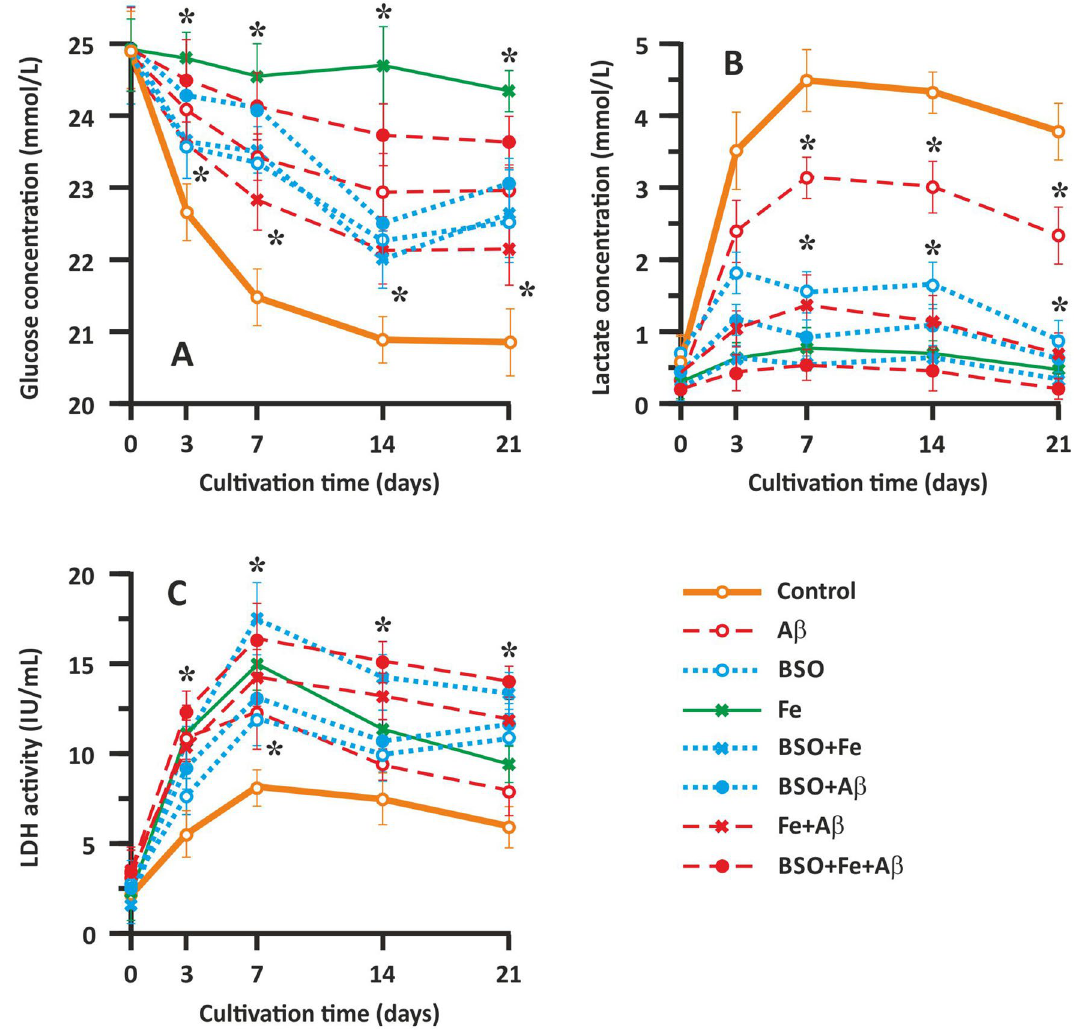
Figure 3. Effect of Aβ, BSO, and Fe 2+ on hippocampal cell metabolism and survival. ( A ) Change in the glucose concentration in the culture medium. ( B ) Change in the lactate concentration in the culture medium. ( C ) Change in LDH activity in the culture medium. Biochemical parameters reflecting cellular metabolism (glucose and lactate levels) and cell damage (LDH activity) in the extracellular medium were measured using Roche Cobas C311 and Cobas E411 automatic biochemical analyzers (Roche Cobas, Switzerland) and appropriate test kits. n = 10. * P < 0.05. The error bars indicate the mean ± count presented above and reflects cell metabolism, which gradually decreased. Fe application almost completely abolished glucose utilization, likely by causing oxidative stress and cell death (Fig. 3A). In the Aβ-treated groups (the Aβ, Fe + Aβ, and BSO + Fe + Aβ groups), intermediate toxicity was observed. Glucose utilization was most markedly affected in the BSO + Fe + Aβ group but less affected in Aβ group (Fig. 3A). The change in glucose content in the culture medium was similar between the Aβ group and the control group. Interestingly, wave- like fluctuations in glucose concentrations were observed in the BSO-treated groups (the BSO, BSO + Fe, and BSO + Aβ groups). Generally, the change in glucose concentrations in these groups was similar to that in the Aβ-treated groups, but there were two periods in which glucose utilization was abolished, i.e., 3–7 day of culture and 14–21 days of culture (Fig. 3A). The change in lactate accumulation in the neuronal cell medium was opposite of the change in glucose concentrations, which is expected and normal for metabolically active cells. In the control group, we observed lactate accumulation until the 7th day of culture, when the analyte concentration reached 4.51 ± 0.49 mmol/l (Fig. 3B). The lactate concentration in the control group gradually decreased after the 7th day and until the end of cultivation and finally reached a value of 3.84 ± 0.42 mmol/l. The change in lactate accumulation in the Aβ-treated groups (the Aβ, Fe + Aβ, and BSO + Fe + Aβ groups) resembled the change in glucose concentrations. The curves representing the change in the lactate concentration in these groups showed the same shape as the curve of the control group, but the concentrations were lower. Cells treated with Aβ alone showed less marked changes, with lactate concentrations reaching the maximal value (3.12 ± 0.27 mmol/l) on the 7th day of cultiva- tion and gradually decreasing to 2.44 ± 0.35 mmol/l (Fig. 3B). In the BSO-treated groups (the BSO, BSO + Fe,